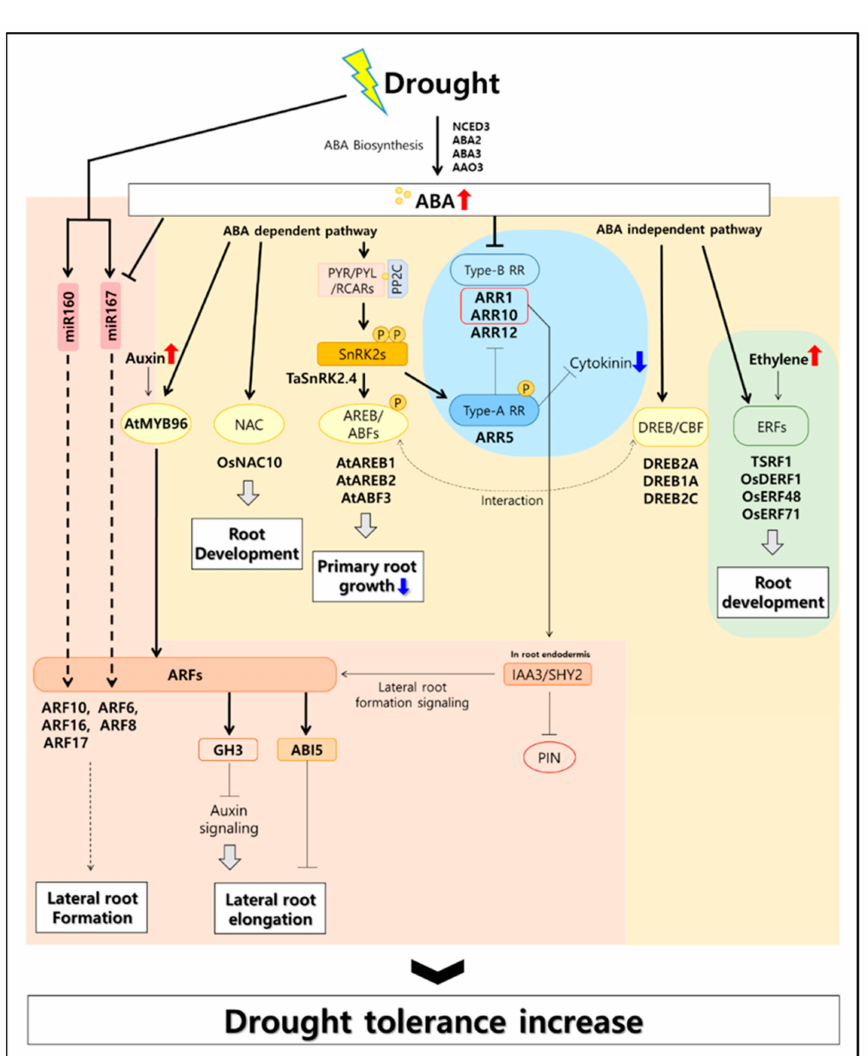
Figure 1. Root-associated hormonal signaling model for drought stress tolerance. In drought, plants induce abscisic acid (ABA) biosynthesis genes to produce large amounts of ABA in plant roots